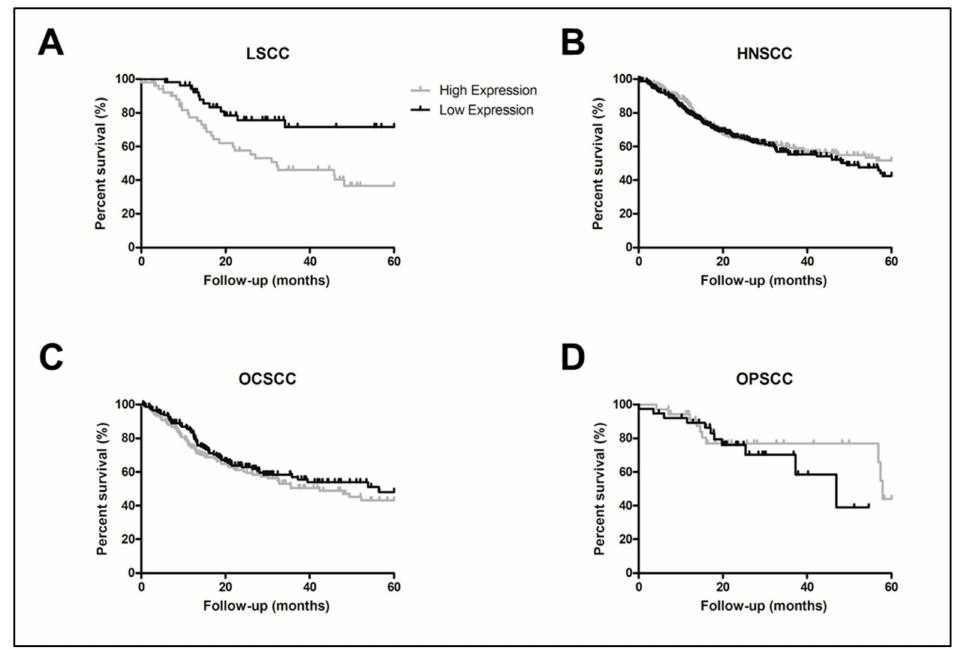
Figure 2. ALCAM overexpression confers worse prognosis to LSCC patients. ( A ) LSCC presenting ALCAM low expression have a better prognosis than LSCC overexpressing ALCAM ( p = 0.01, HR = 2.74, 95% CI 1.26–5.97). The association with prognosis seems to be specific to LSCC among HNSCC tumors. ALCAM expression was not associated with prognosis analyzing all head and neck squamous cell carcinoma (HNSCC) together ( B ) or separately, oral cavity (OCSCC) ( C ) and oropharnyngeal (OPSCC) ( D ). Legend: Black line, ALCAM low expression; grey line, ALCAM high expression. Groups were made according to ALCAM expression median